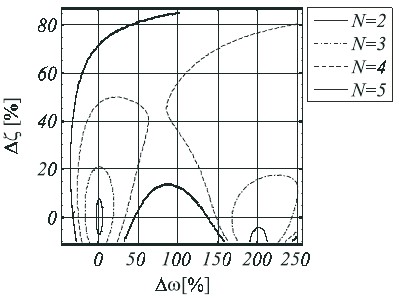
Fig. 2. Error margins between actual and estimated frequency and damping with maximum overshoot A amp < 0 . 05 , low damping ratio ( ζ = 0 . 1)